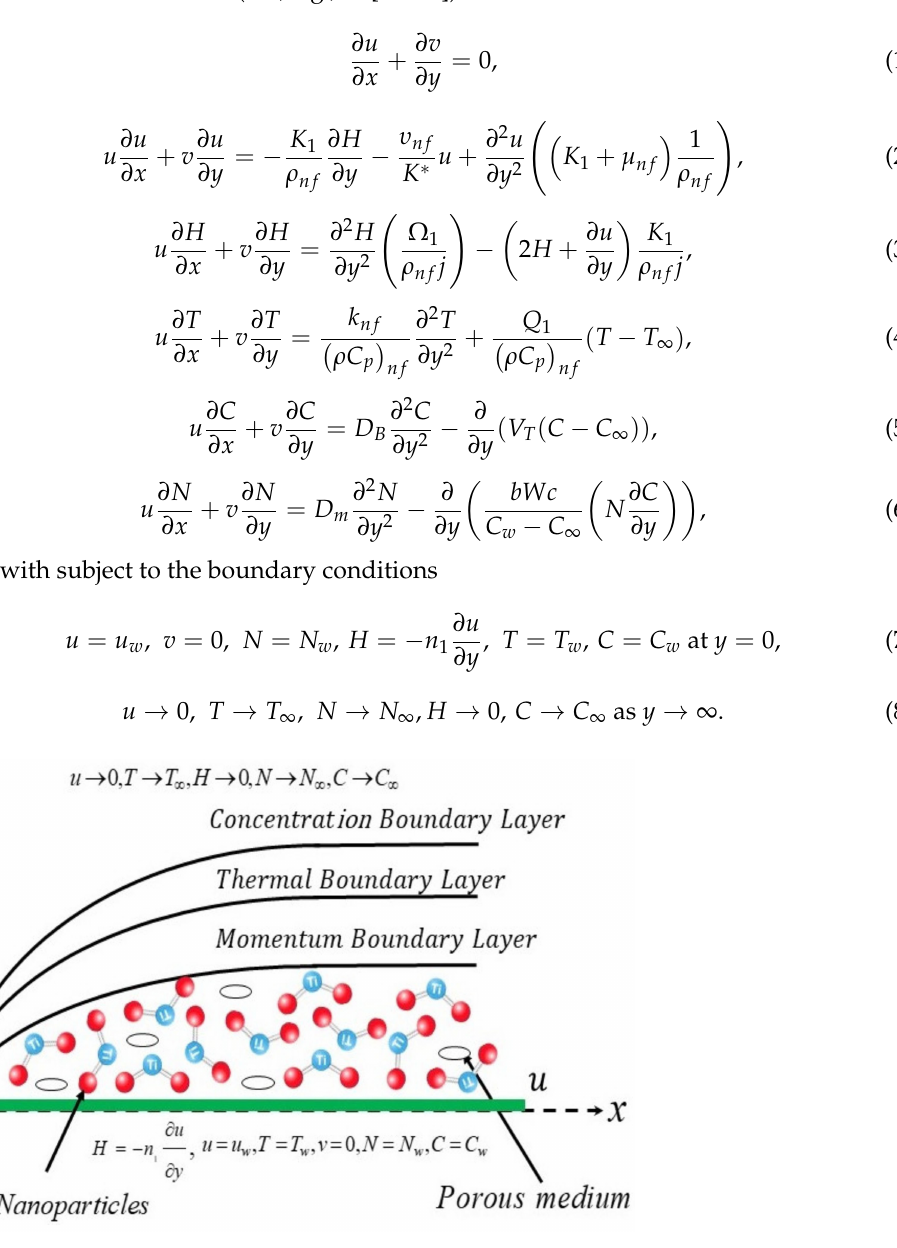
Figure 1. Physical model of the